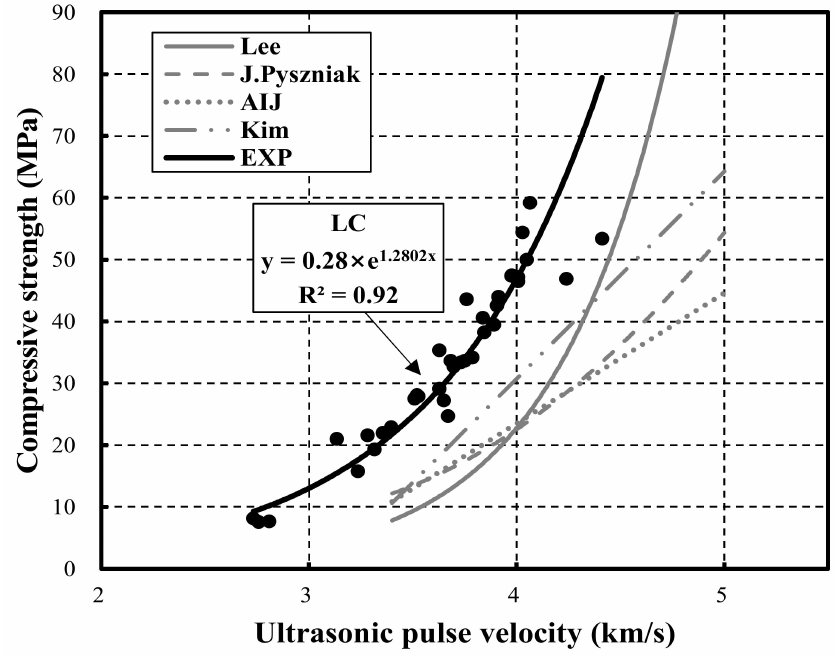
Figure 10. Comparison between previous prediction equations and the herein-proposed estima- tion